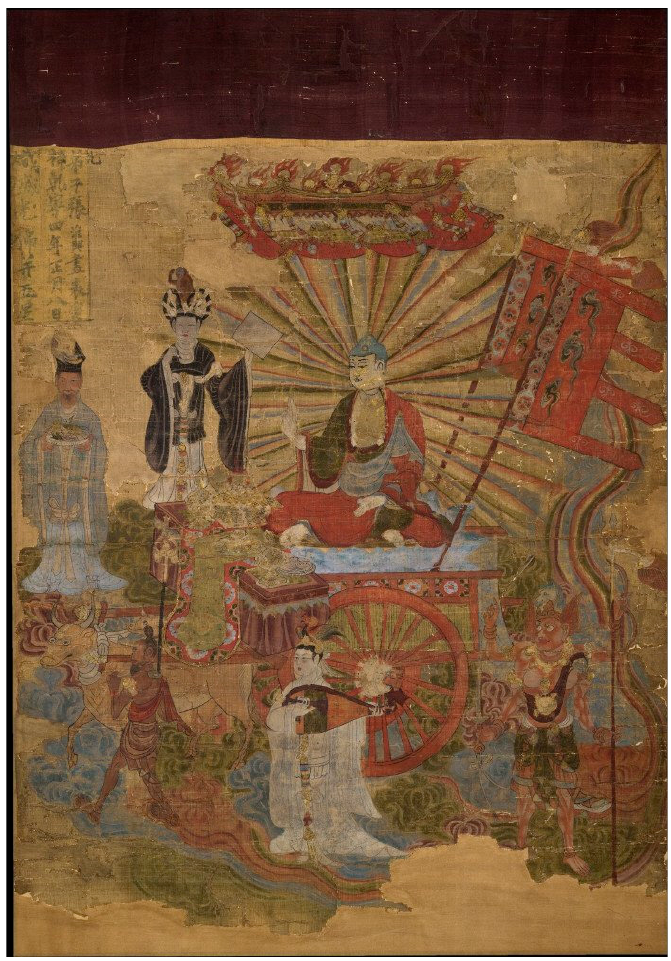
Figure 1. Chisheng guangfo yu wuxingsheng 熾盛光佛與五星神 (Tejaprabh ā Buddha and Five Deities of Stars), British Museum, Ink and colors on silk, From Cave 17, Dunhuang Mogao Caves, 80.40 cm × 55.40 cm, Dated 897.